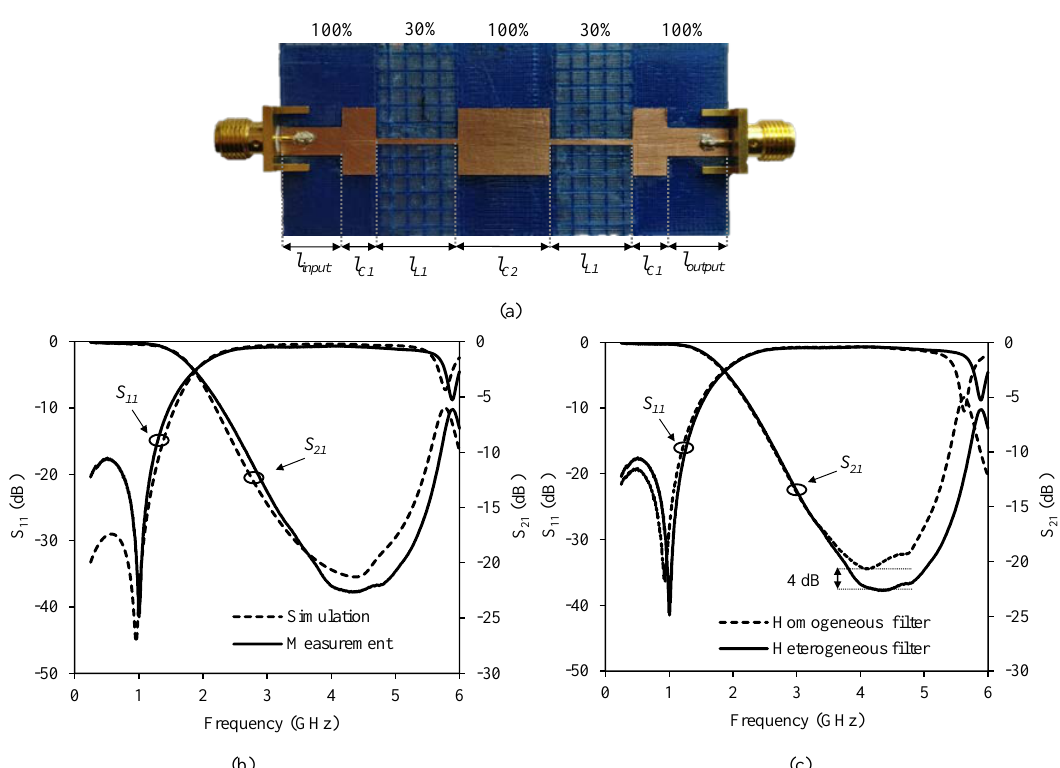
Figure 12. ( a ) Stepped impedance filter manufactured with different densities. ( b ) Measured and simulated response of the stepped impedance filter with different densities. ( c ) Comparison measurements of the different filters.